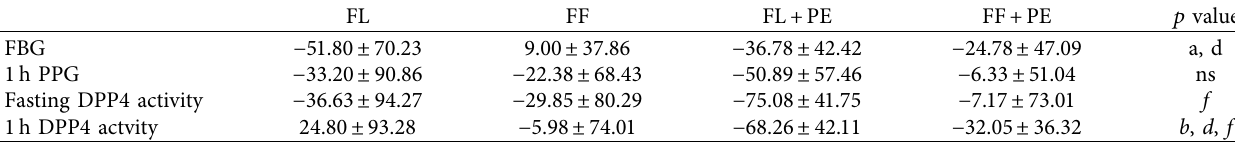
Table 2: Te mean changes of each treatment after a 7-day course of